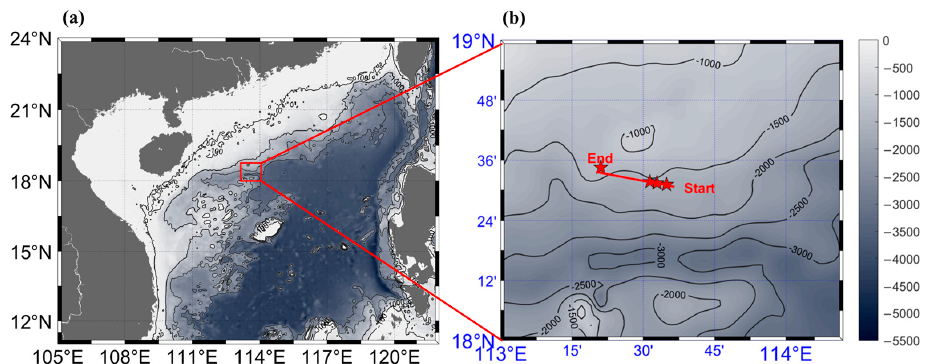
Figure 3. ( a ) Topography of the nSCS and the measuring area. ( b ) A larger image of the region enclosed by the red rectangle in panel ( a ), displaying the hybrid AUV path’s start and end points as well as the surrounding bathymetry. Color in both panels denotes the depth (m) of the water.